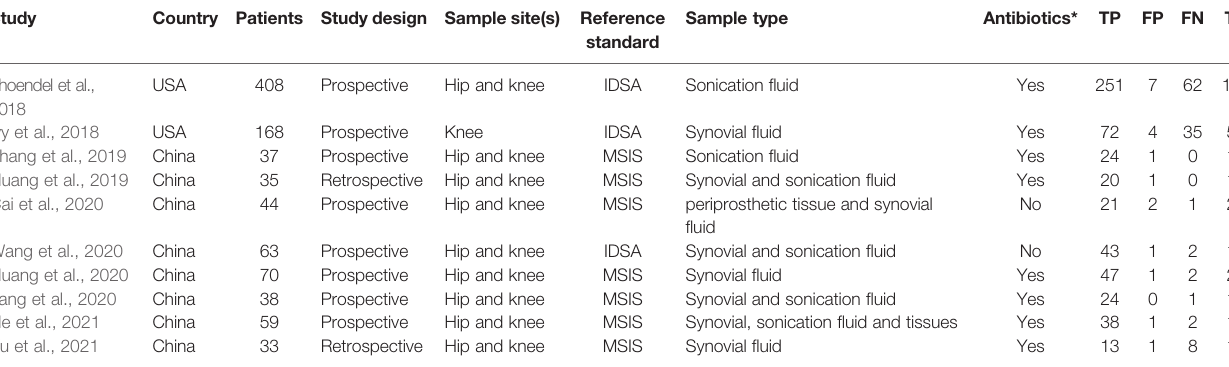
TABLE 1 | Characteristics of the studies that were